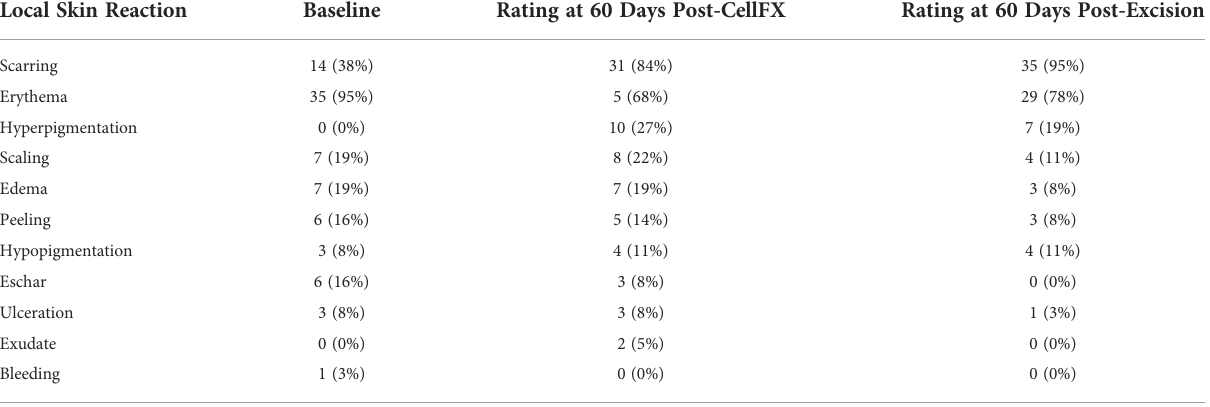
TABLE 2 Local Skin Reactions Post 60-Days (CellFX vs. Standard Surgical Excision). Local Skin